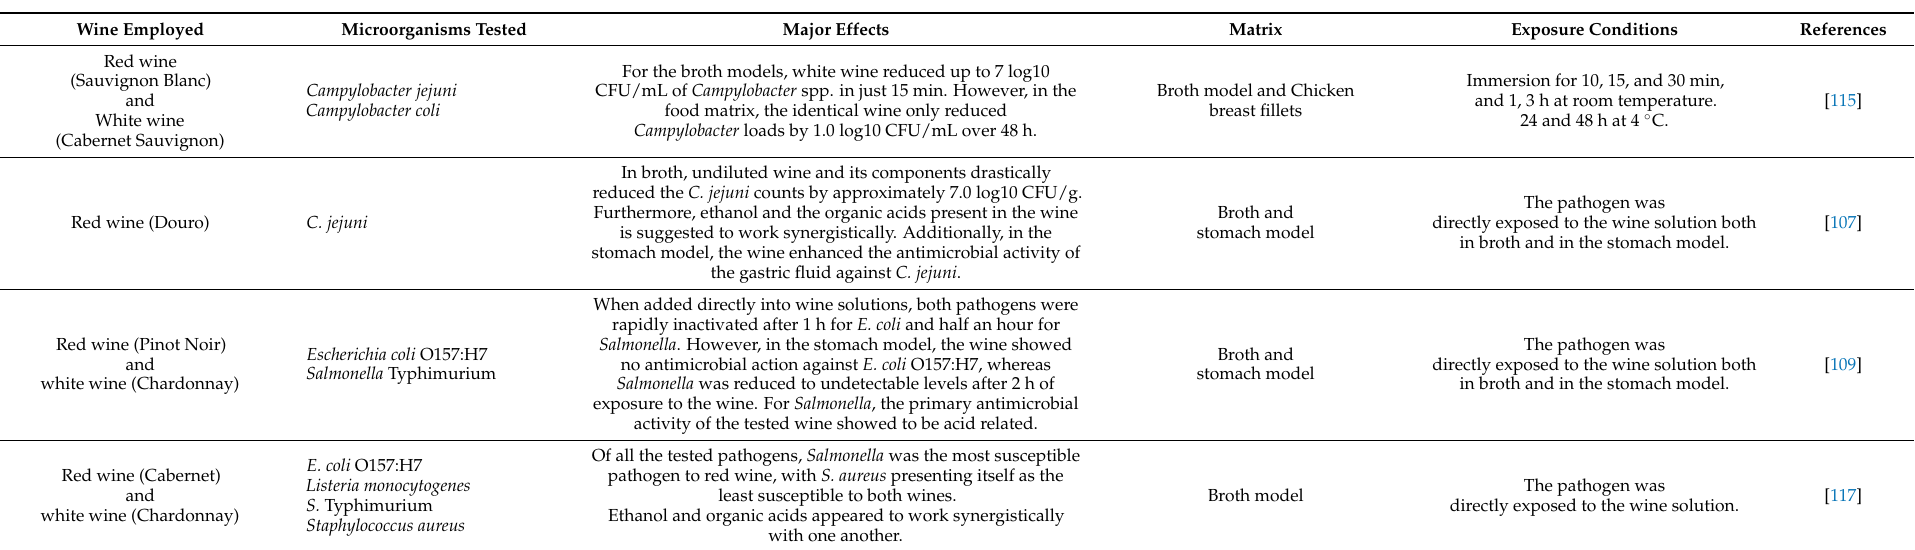
Table 4. Studies evaluating the antimicrobial activity of